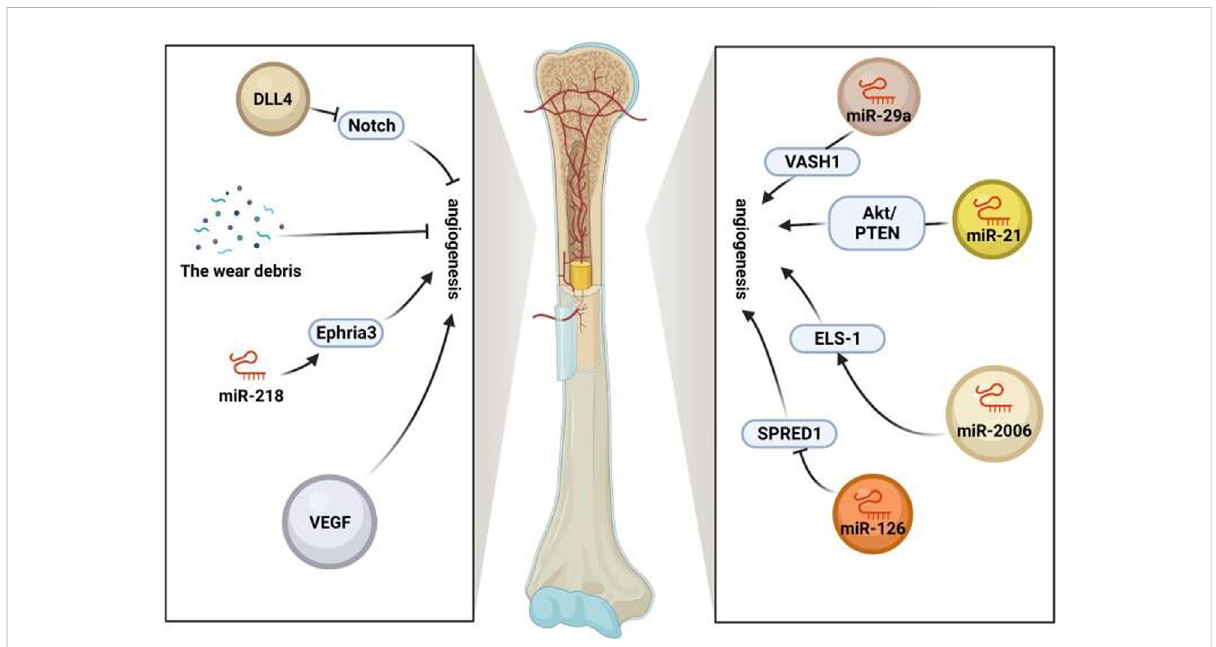
FIGURE 2 Role of exosomes in vessels. Stem cell exosomes play various vital roles in the aseptic loosening of prosthesis, including hematopoietic stem cellssupportingperivascularnichesandrepairingandregeneratingdamagedbone,cartilage,andvasculartissue.AngiogenesisispromotedbyVEGF, miR-218-Ephria3, miR-29a-VASH1, miR-21-PTEN/Akt, and miR-2006-ELS-1 while inhibited by the wear debris, miR-126-SPRED1, and notch